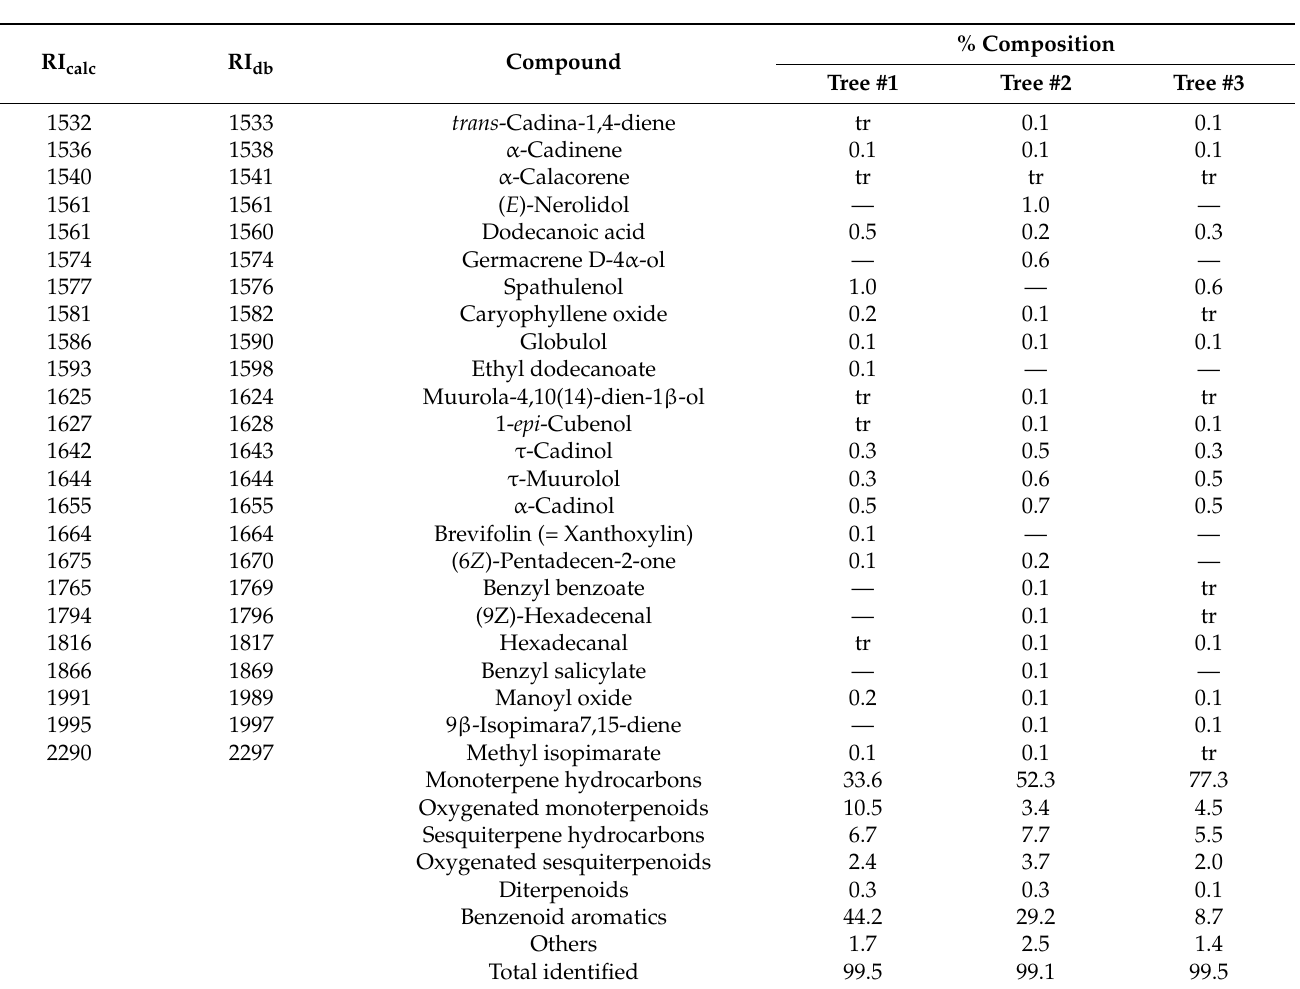
Table 2. A total of 55 compounds were identified accounting for 98.2% of the essential oil composition. The dominant components in the essential oil were the monoterpenoids β -phellandrene (23.8%), terpinen-4-ol (11.0%), thymol (6.6%), and chavicol (5.3%). Adams and co-workers have reported the leaf essential oils of P. contorta subsp. contorta , P. contorta subsp. latifolia , and P. contorta subsp. murrayana [23]. There are some notable